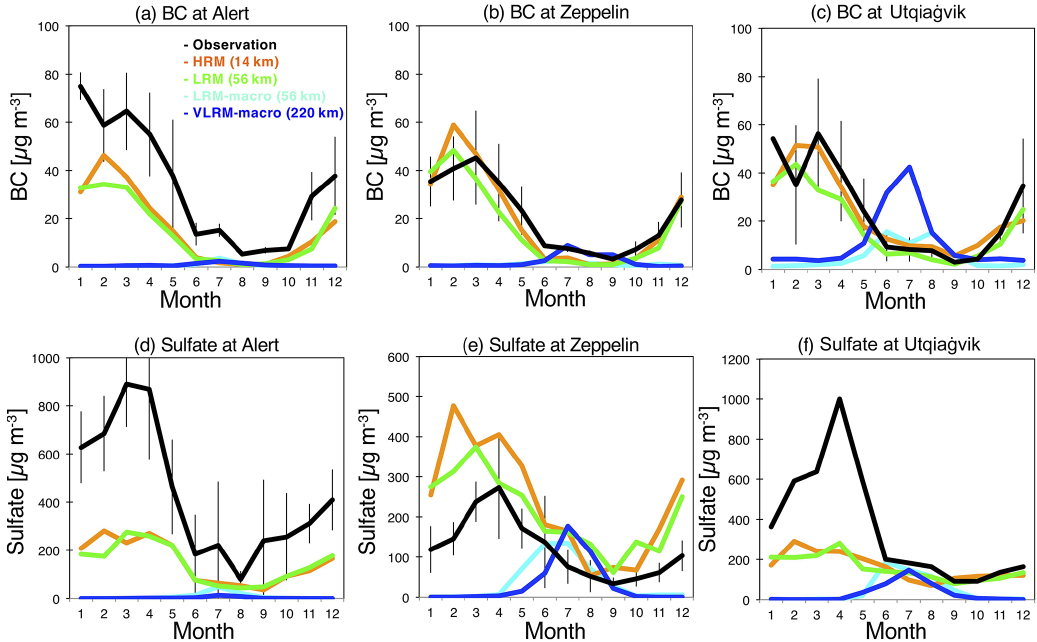
Figure 12. Monthly averages of BC and sulfate concentrations simulated by the HRM, LRM, LRM with a cloud macrophysics module (LRM-macro, which is defined in Sect. 2.1) and VLRM-macro (NICAM simulations using a horizontal grid spacing of 220km with the cloud macrophysics module, which is defined in Sect. 2.1) at three Arctic sites: Alert (62.3 ◦ W, 82.5 ◦ N), Zeppelin (11.9 ◦ E, 78.9 ◦ N) and Utqia˙gvik (157.0 ◦ W, 71.3 ◦ N). The BC is measured as the equivalent BC at 530nm by a particle soot absorption photometer (PSAP) for 2007–2011 under the EMEP database. The sulfate concentrations are averaged at Alert for 2000–2006 by the Canadian Arctic Aerosol Chemistry Program (CAACP) in the National Atmospheric Chemistry (NAtChem) database, at Zeppelin for 2005–2013 by EMEP and at Utqia˙gvik for 2008–2009 by Eckhardt et al.